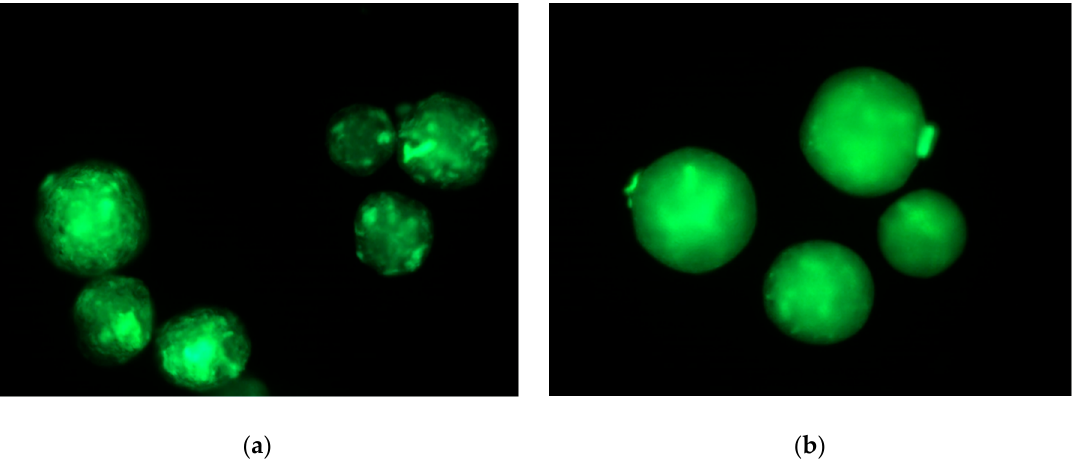
Figure 5. Micrographies of FITC-stained microparticles made from 30 wt. % of CPLG ( a ) and CPG ( b ) observed under fluorescence microscopy (Ex / Em 495 / 519 nm, respectively).